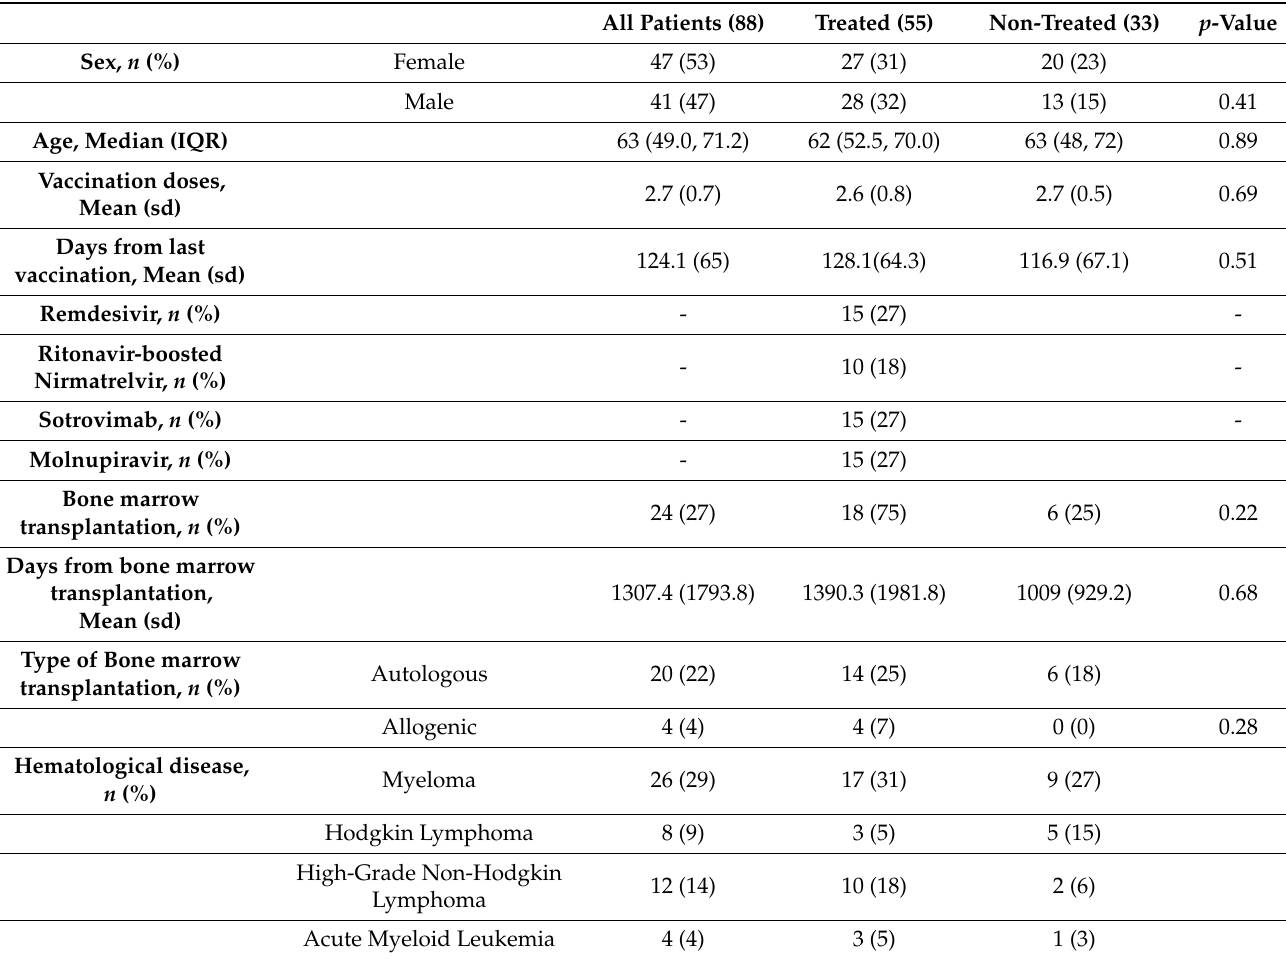
Table 1. Table 1. Demographic and clinical